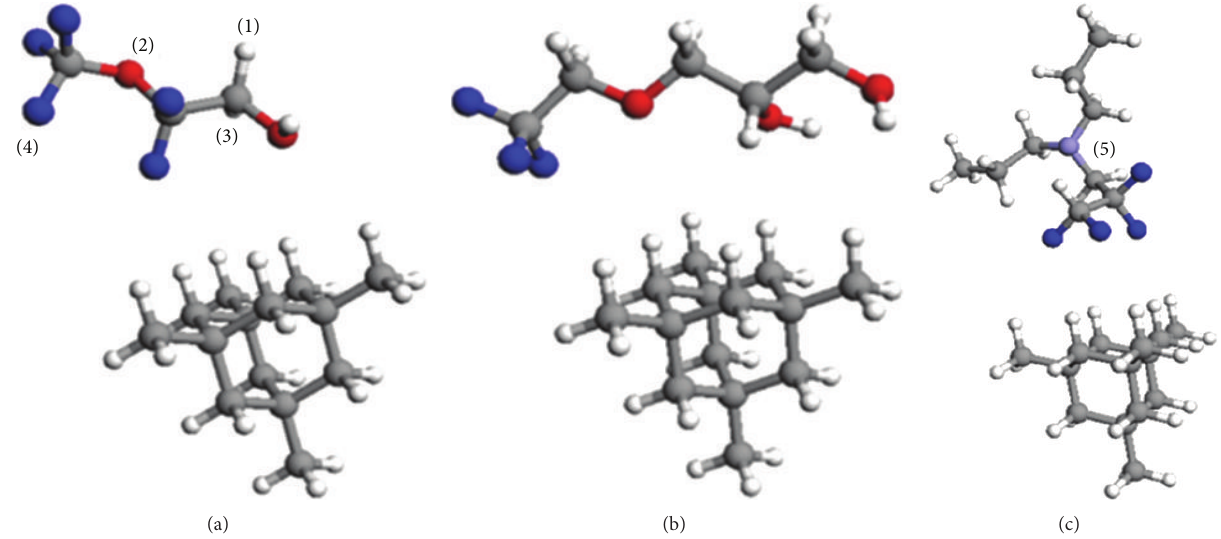
Figure 6: The relaxed PFP-diamond dimers for (a) Z-dol, (b) Z-tetraol, and (c) DDPA. White = hydrogen, red = oxygen, grey = carbon, blue = fluorine, and violet = nitrogen.